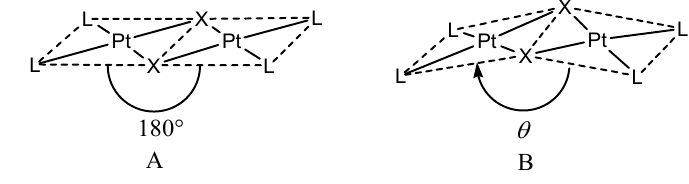
Figure 1. Planar ( A ) or bent ( B ) edge-sharing binuclear complexes of